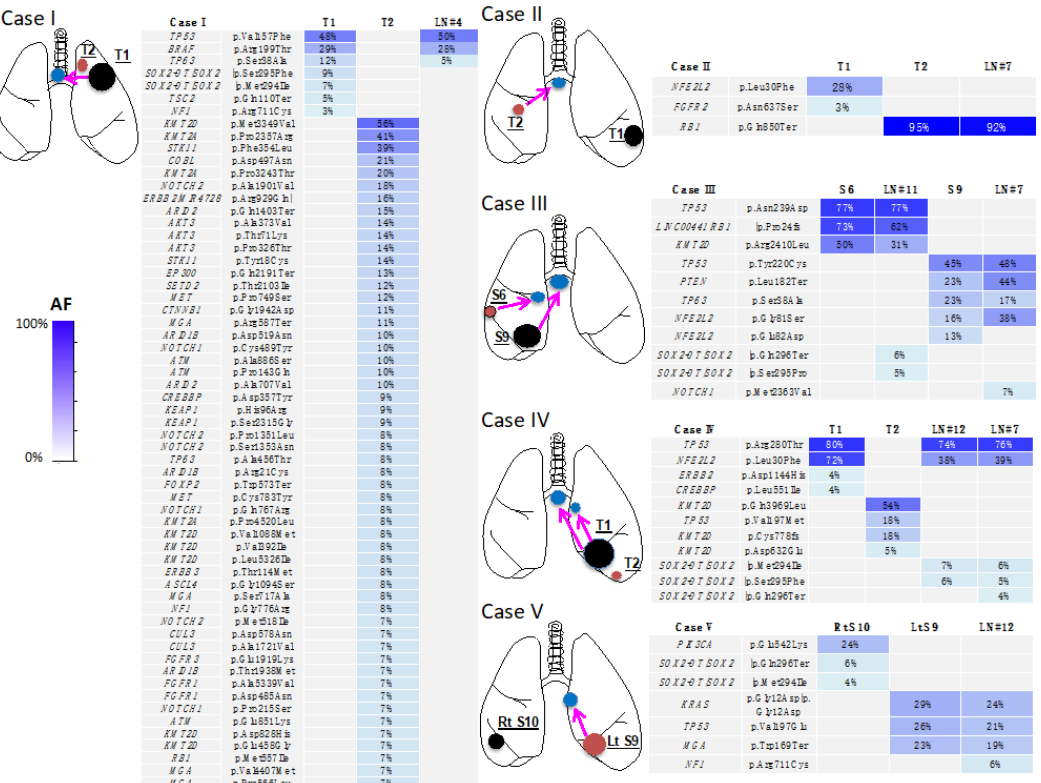
Figure 6. Schema of lymphatic metastasis and mutation profiles in multiple lung cancers. On the basis of the coincidence and differences in the mutation profiles, the clonality of each tumor and the pathway of lymphatic progression are clearly elucidated in each case. The arrows indicate the lymphatic routes of the cancer invasion. Tumor 1 is shown in black, tumor 2 in red and lymph node metastasis in blue. #4, tracheobronchial lymph node; #7, subcarinal lymph node; #11, interlobar lymph node; and #12, hilar lymph node. S, segment; LN, lymph node; AF, allele fraction.